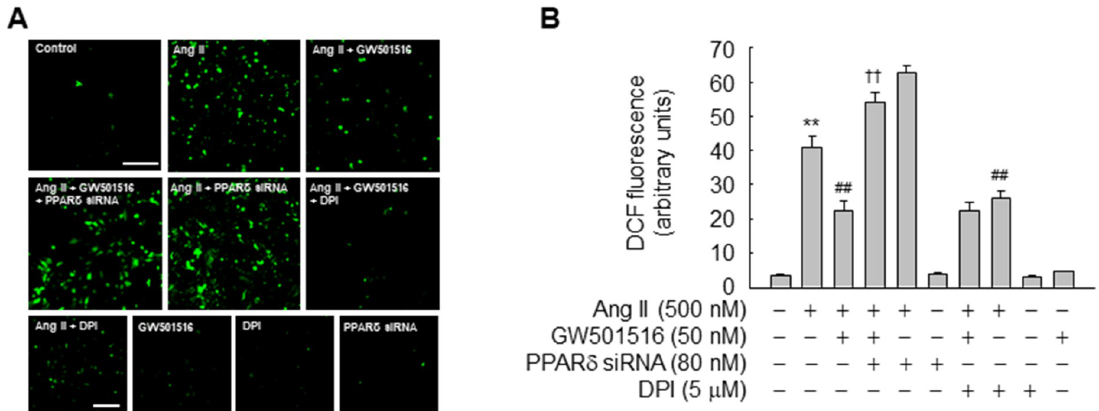
Fig 2. GW501516-activated PPAR δ suppresses Ang II-induced generation of ROS in VSMCs. VSMCs transfected with PPAR δ - targeting siRNA for 48 h or pretreated with DPI for 30 min were incubated in the presence or absence of GW501516 for 24 h and then treated with Ang II for 24 h. Intracellular ROS were detected by confocal laser fluorescence microscopy using the peroxide-sensitive dye CM-H 2 DCF-DA (10 μ M, A), and the fluorescence intensity was quantified (B). Data represent means ± SE (n = 5). Bars, 200 μ m. �� p < 0.01 compared with the untreated group; ## p < 0.01 compared with the Ang II-treated group; and †† p < 0.01 compared with the Ang II plus GW501516-treated